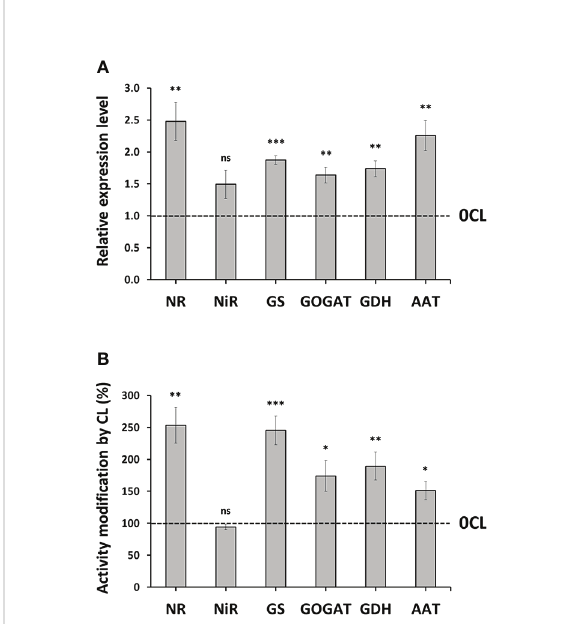
FIGURE 4 Effect of Cl − nutrition on enzymes involved in N assimilation. Tobacco plants were treated with 0 and 6 mM of Cl − salts (CL), and supplemented with a mix of sulphate+phosphate salts to maintain a similar cationic balance. Transcript abundance (A) and activity (%) (B) of 6CL plants normalized to 0CL plants showed in different N metabolism-related enzymes: nitrate reductase (NR), nitrite reductase (NiR), glutamine synthetase (GS), glutamate synthase (GOGAT), glutamate dehydrogenase (GDH), and aspartate aminotransferase (AAT). Mean values ± SE, n =4-6. Statistics in (B) was calculated through ANOVA. Levels of signi fi cance: * P ≤ 0.05; ** P ≤ 0.01; *** P ≤ 0.001; and ‘ ns ’ P > 0.05. The dotted line represents the normalized activity in 0CL